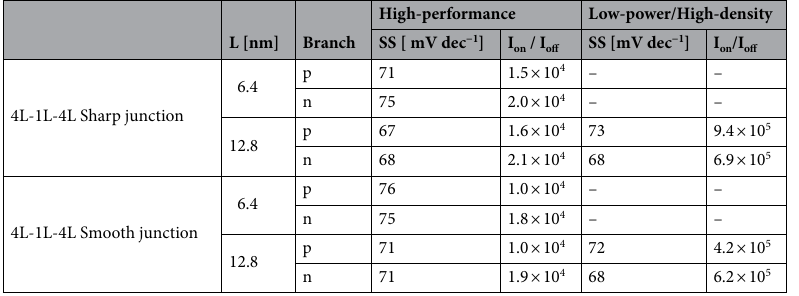
Table 2. Figures of merit for 4L-1L PtSe 2 FETs. All figures of merit were obtained fixing the supply voltage V DS = 0.5 V, and by mapping E on-site from DFT. The IV curves from which the data were extracted are reported in Fig.